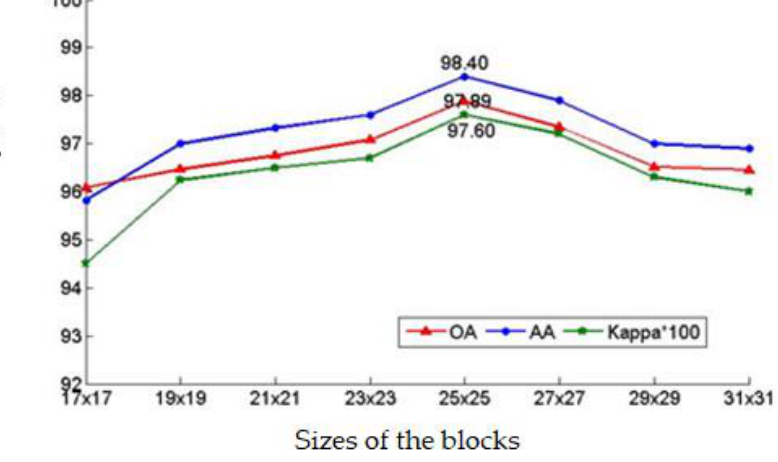
Figure 13. The influence of different block sizes on classification accuracy.